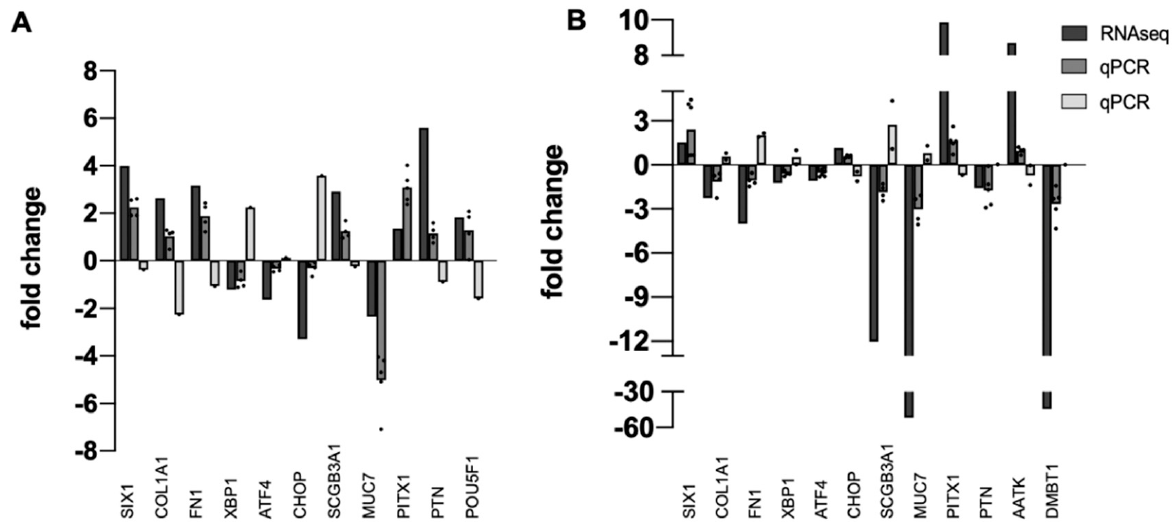
Figure 1. Validation of RNA-seq Data. Bar graph showing the relative correlation between RNA-seq data and qPCR data. ( A ) pinguecula vs. conjunctiva. ( B ) pterygium-E vs. conjunctiva. Black bars indicate fold change of gene transcripts in RNA-seq data; gray bars indicate fold change of gene transcripts determined by qPCR (dark gray = downregulated; light gray = upregulated). A normalized ratio (Y-axis) of more than 1 indicates upregulation, whereas a ratio of less than one indicates downregulation. The X-axis shows a random selection of 13 genes, n = 4 or 5 for each determination, with dot plots used to display the range of data